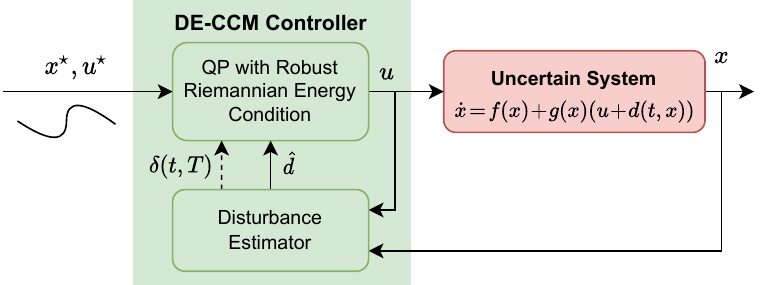
Figure 1. Block diagram of the closed-loop system with the proposed DE-CCM